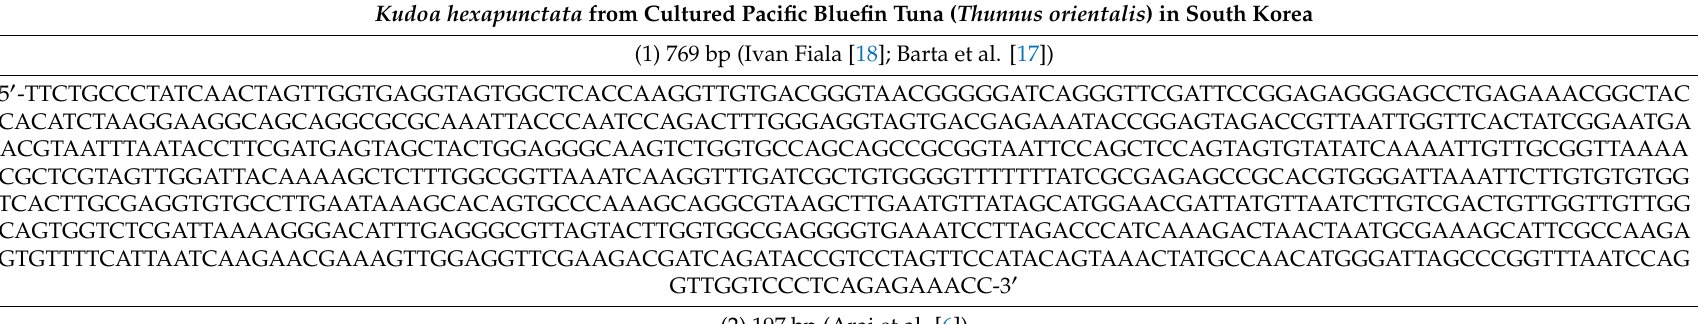
Table 4. Sequence data of first and secondary polymerase chain reaction (PCR)